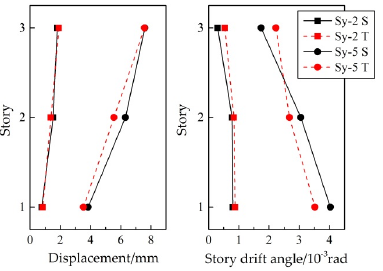
Figure 11. Comparison of structure overall response under different conditions.